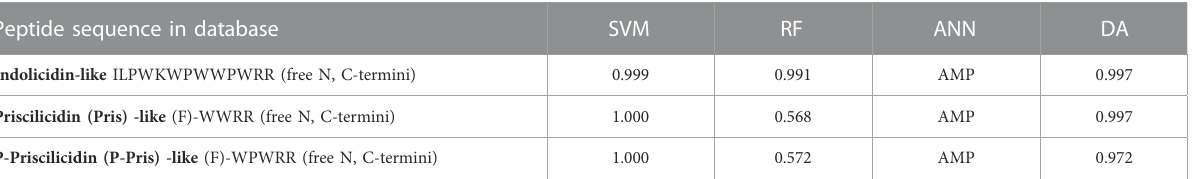
TABLE 1 Antimicrobial activity predictions from different algorithms in the CAMP database. Peptide sequence in database